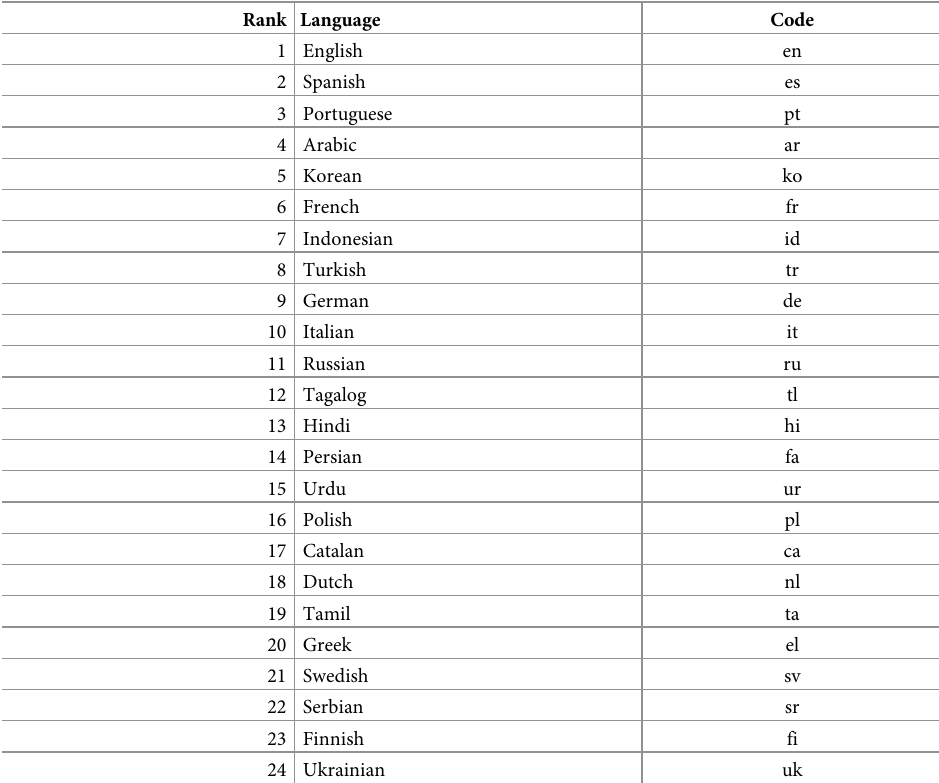
Table 1. The 24 languages for which we provide COVID-19 related Twitter time